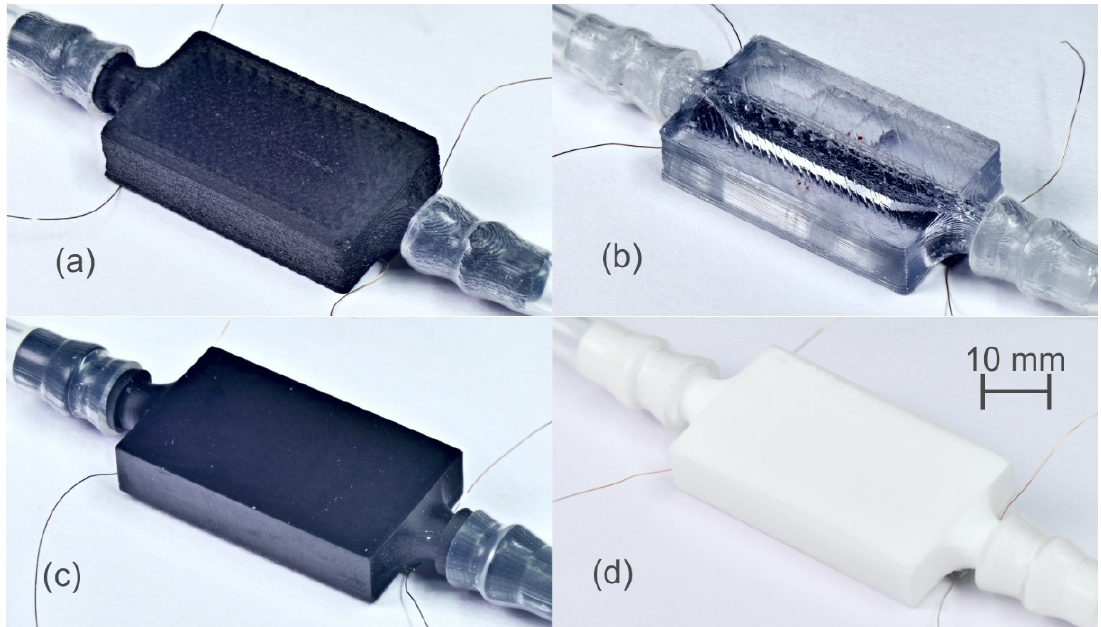
Sensors 2021 , 21 , x FOR PEER REVIEW Figure 4. Top view of the fabricated liquid cells using different materials. ( a ) PA-CF, ( b ) PET, ( c ) black resin and ( d ) Rigid10K resin.